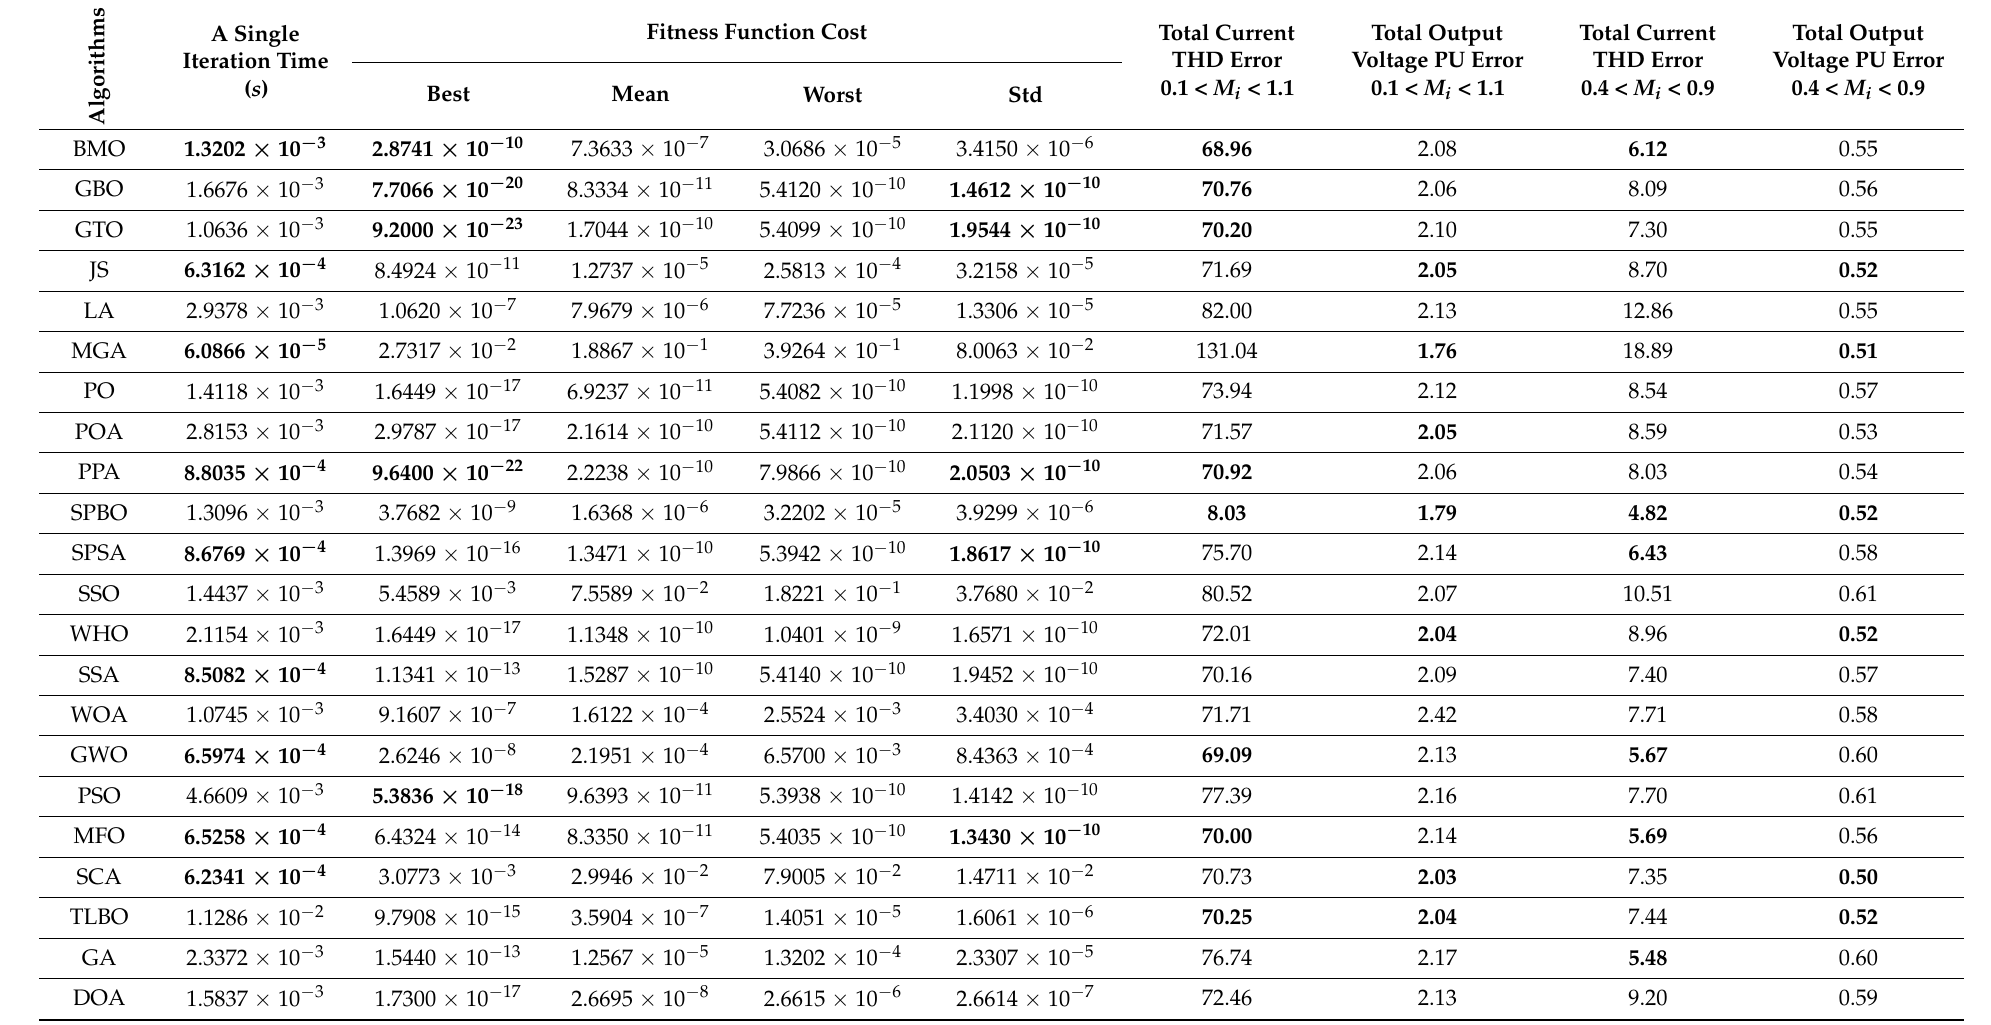
Table 4. Comparison of statistical values of the fitness function’s cost, current total harmonic distortions, and output voltages in algorithms applied to the 11-level SHEPWM problem (the prominent values are highlighted in